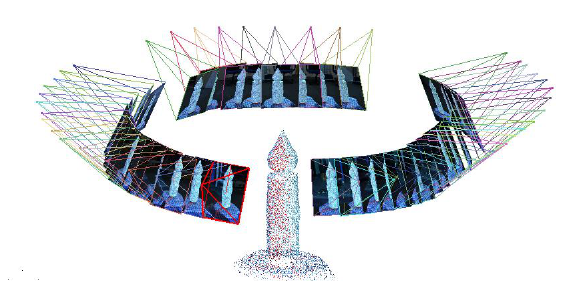
Figure 11: Result of Structure from Motion reconstruction by the software VisualSfM. Orientations and sparse point cloud for 46 images. In order to compare the difference to the reference surface visually, the software Cloud Compare (http://www.danielgm.net/cc/) was used. A difference to the mesh was computed and visualized, as shown in figure 12. The results indicate the improvement of the precision with increasing angles and the improvement due to high redundancy by means of many stereo models, as visible in the second image. Here, each pixel is observed in many images, which enables outlier rejection and noise reduction. The unexpected inhomogeneous distribution of the error indicates errors of the exterior